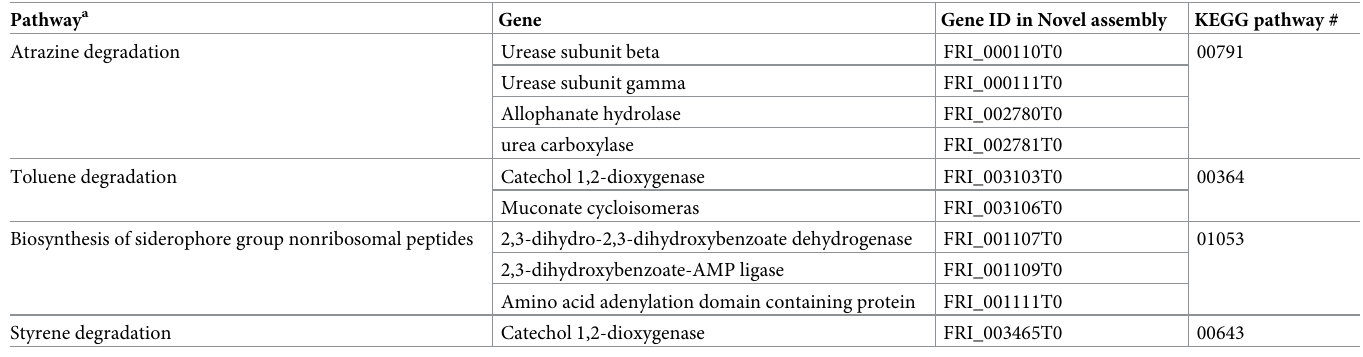
Table 1. Unique biosynthetic genes of B . frigoritolerans A3E1 compared to its reference DSM (8801). Pathway